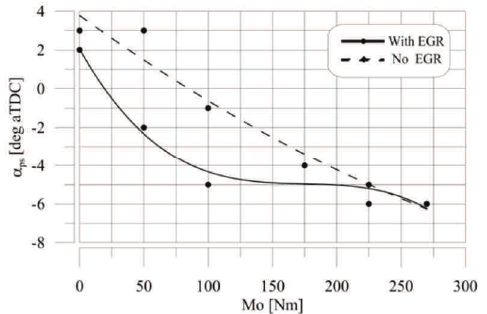
Fig. 10. Influence of the engine load on start of combustion a ps for engine operating with/without EGR